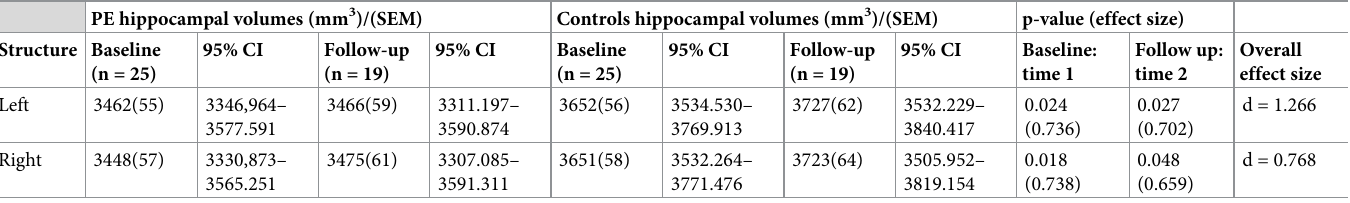
CI, confidence interval; SEM, standard error of the